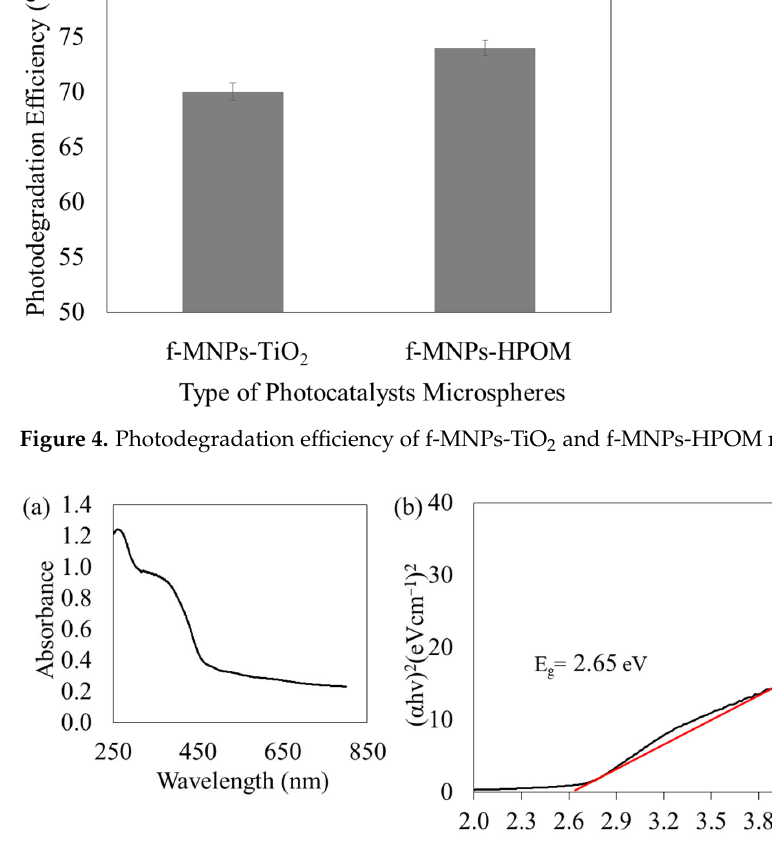
Figure 6. Corresponding plots for f ‐ MNPs ‐ TiO 2 and f ‐ MNPs ‐ HPOM microspheres ( a ) The pseudo ‐ first ‐ order reaction and ( b ) kinetic constants for photocatalytic degradation for MO. The stability of a photocatalyst is of major concern; thus, the reusability of HPOM microspheres for MO photodegradation with UV light was evaluated for three cycles. Af ‐ ter 90 min of irradiation, the microspheres were separated from the reaction mixture using a magnet, washed with distilled water, and reused for repeated MO photodegradation tests. As shown in Figure 7, only a nominal and gradual decrease in the photocatalytic performance could be observed, and nearly 70% photodegradation efficiency was re ‐ tained throughout the three cycles. The slight reduction in photodegradation efficiency during the second and third cycles might be due to the reduced active site on the surface of photocatalyst particles. The microsphere surface could be saturated with the deposition of MO, which caused fewer photons to be available to reach the microsphere surface, and ultimately caused the decrease in the formation of free hydroxyl radicals [24].